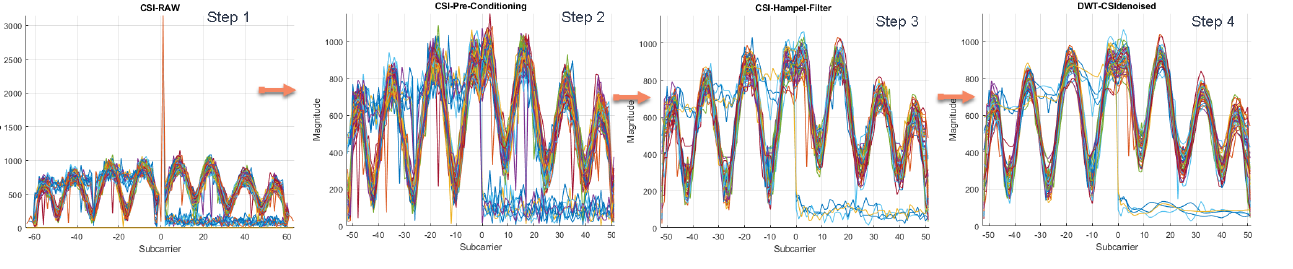
Figure 6. CSI denoising